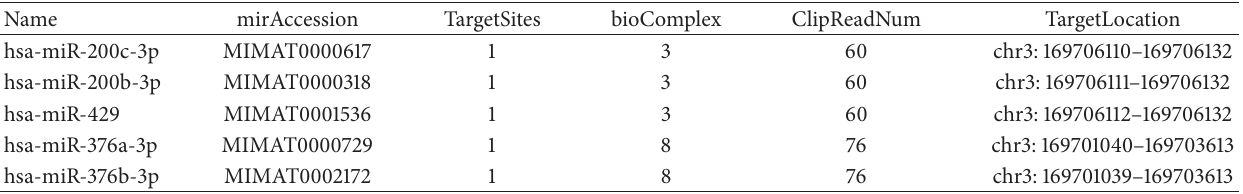
Table 2: The table showed the five miRNAs predicted to interact with SEC62 and hsa-circ-0001358. The clip read numbers were the total reads found in ClipSeq experiments. The bioComplex column represented the numbers of the high-throughput sequencing of RNA isolated by crosslinking immunoprecipitation (AGO2 HITS-CLIP) of 𝑛 cell